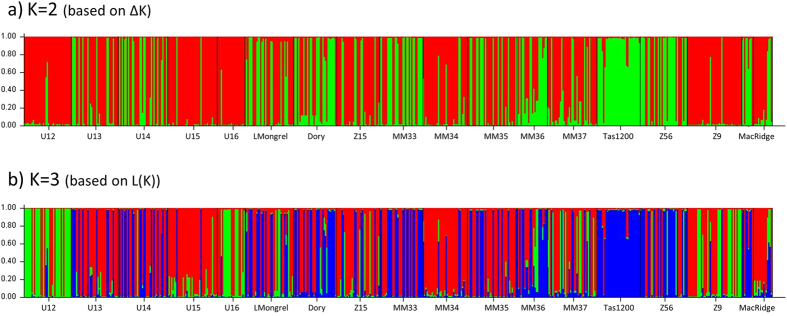
Genetic groups within Solenosmilia variabilis based on output from STRUCTURE analysis and grouped by seamount sampling location.